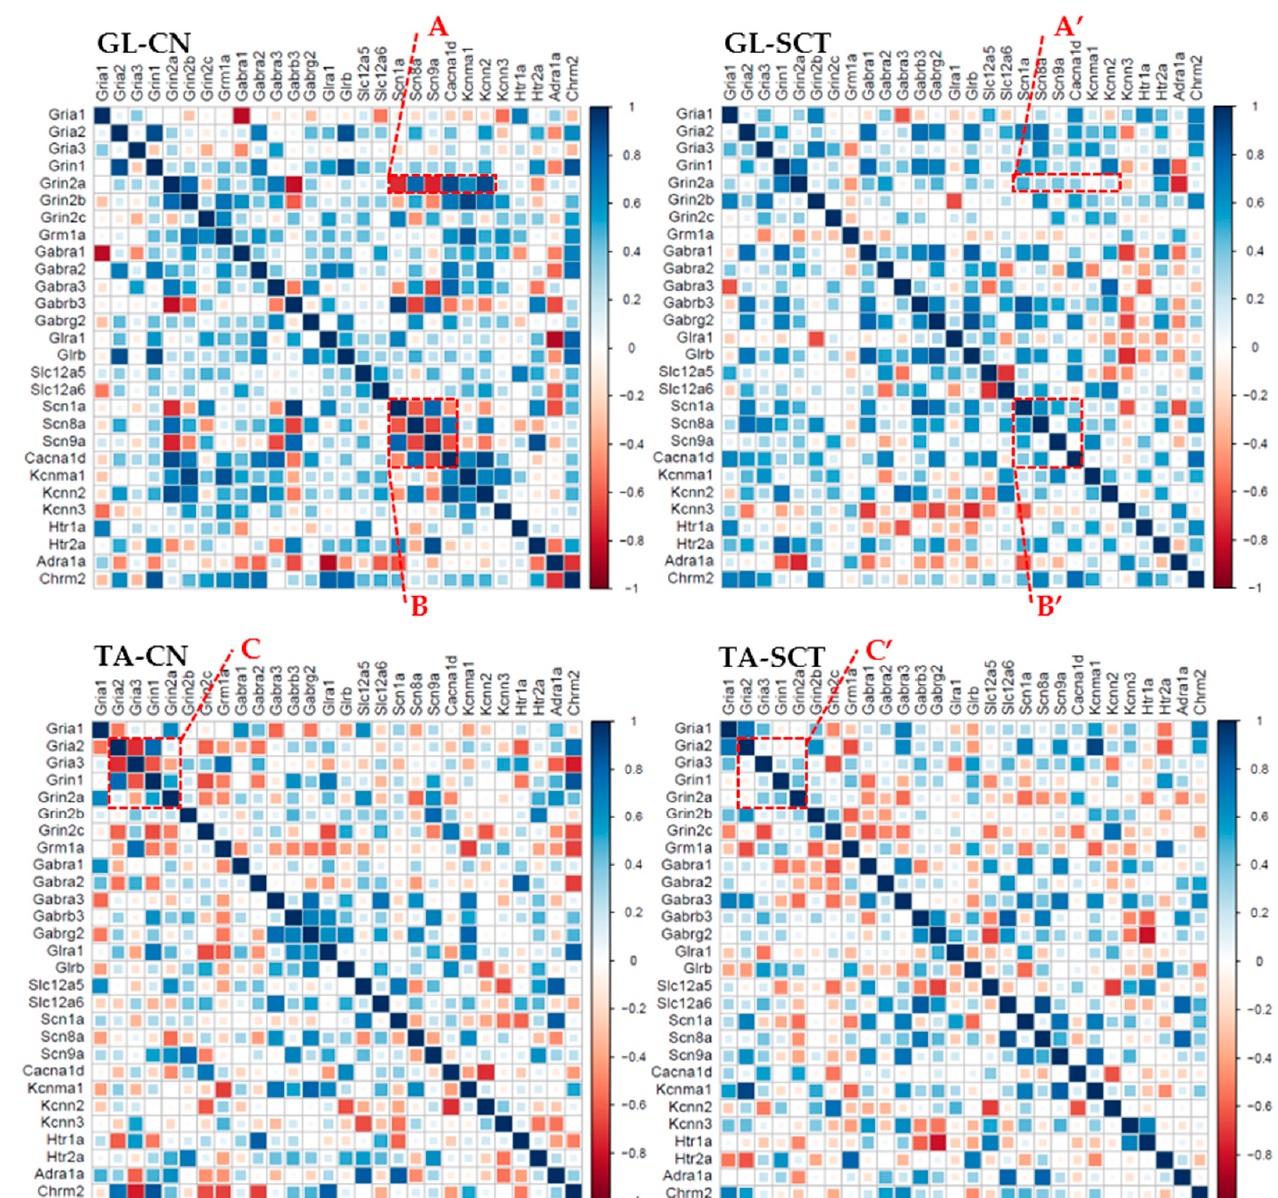
Figure 7. Changes in correlated gene expression as a result of SCT in GL and TA MNs. The order of the genes along the X- and Y-axis of each correlogram is the same for comparing the changes between groups.